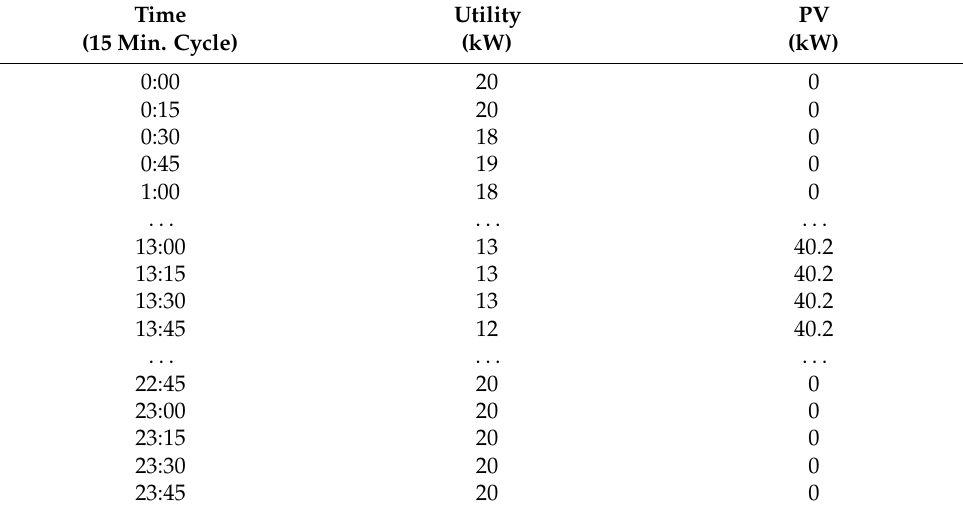
Table 2. Utility grid power supply and PV street generation in Case 1 (Normal Grid